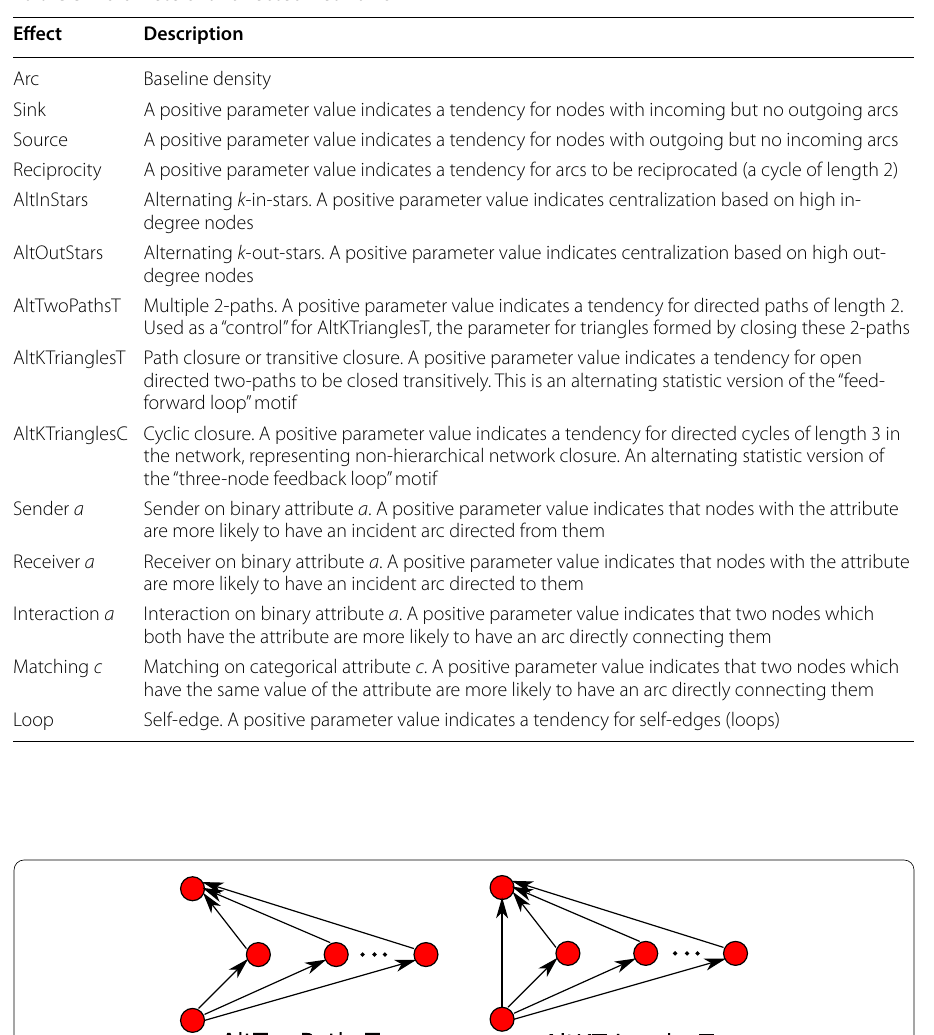
Table 3 Parameters for directed networks